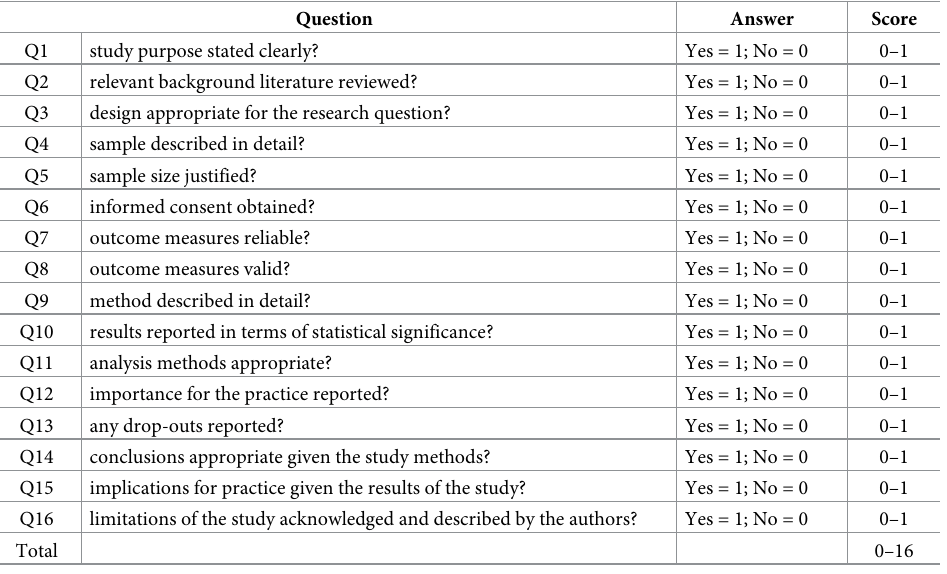
Table 3. Methodological quality assessment scoring